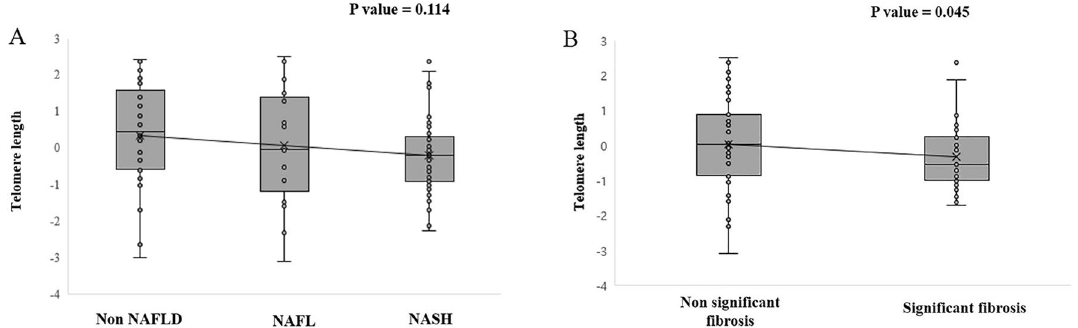
Figure 5. Correlation between telomere length and the histological spectrum of NAFLD. ( A ) Correlation between telomere length and NAFLD: telomere length tended to be shorter in the order of non-NAFLD, NAFL, and NASH ( p = 0.114). ( B ) Correlation between telomere length and significant fibrosis: telomere length tended to be shorter in NAFLD patients with significant fibrosis than those without significant fibrosis ( p = 0.045). NAFLD non-alcoholic fatty liver disease, NAFL non-alcoholic fatty liver, NASH non-alcoholic